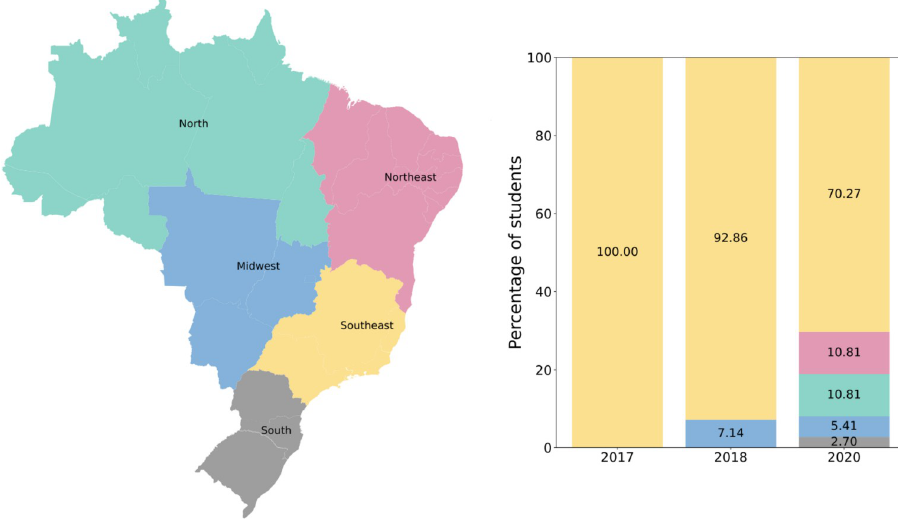
Fig 2. Brazil map to show the geographic distribution of participants who attended the Brazilian Python Workshop for Biological Data over the years (https://www.ibge.gov.br/geociencias/organizacao-do-territorio/